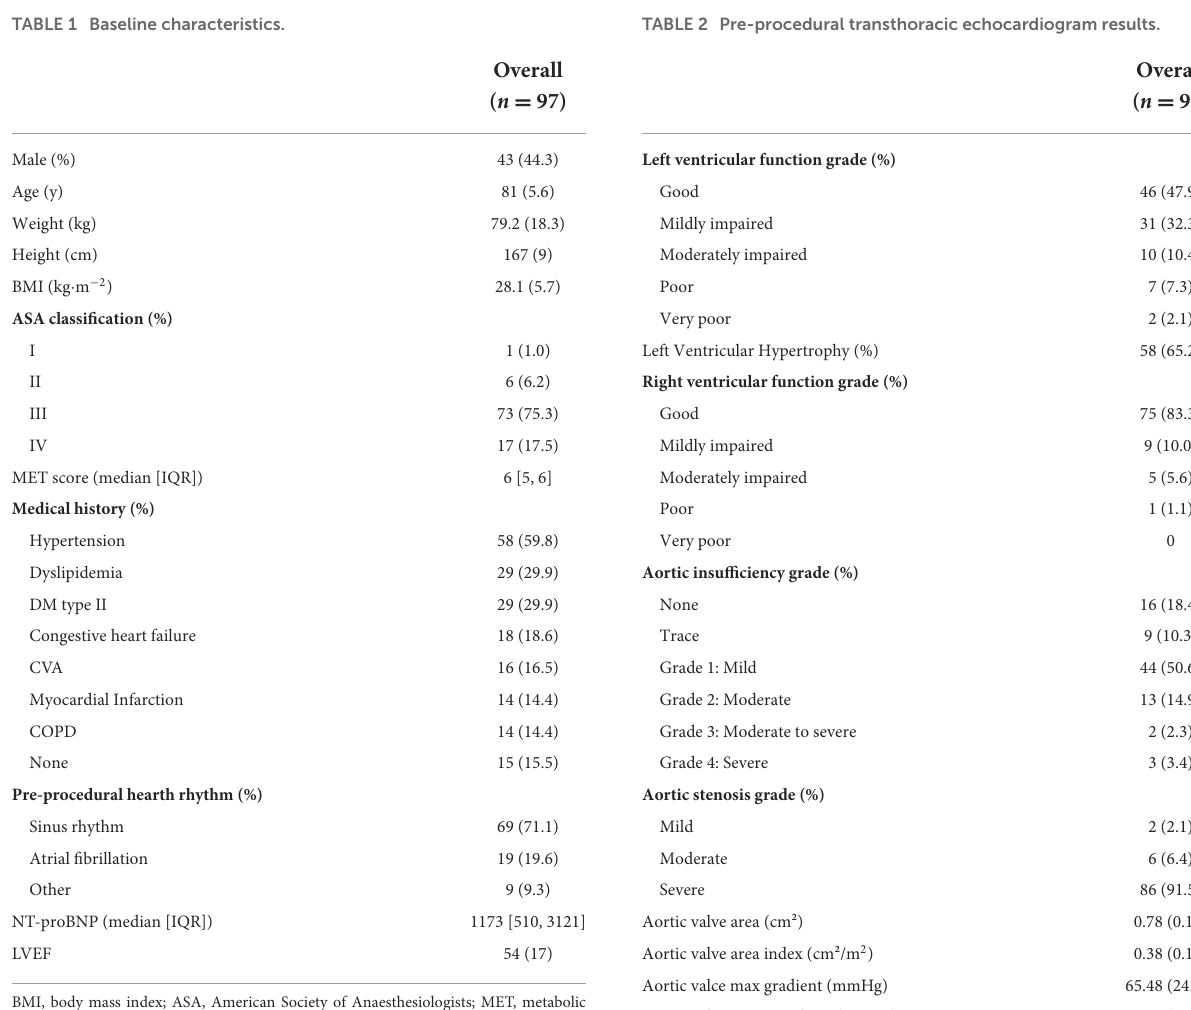
TABLE 1 Baseline characteristics. TABLE 2 Pre-procedural transthoracic echocardiogram